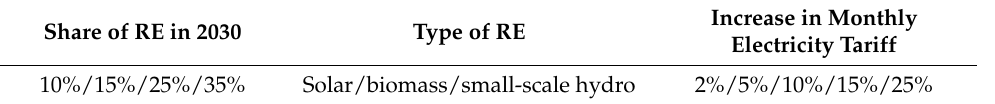
Table 2. Attributes and their levels for the